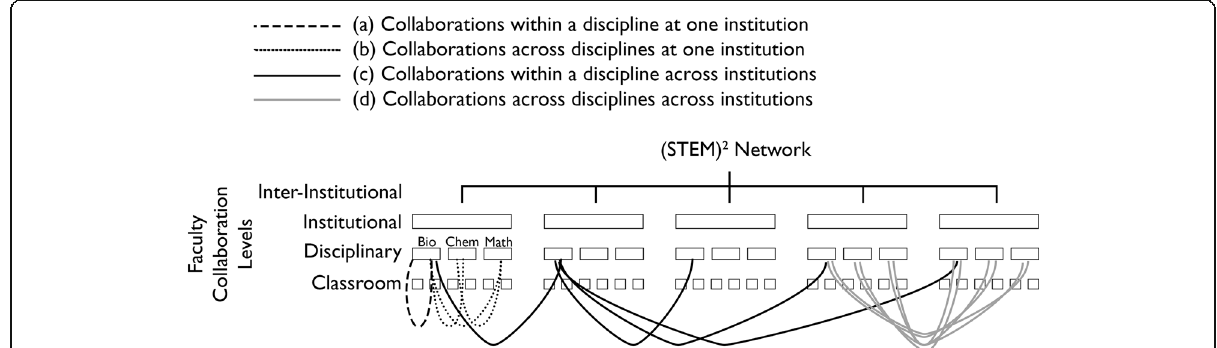
Fig. 1 Four levels of faculty collaboration promoted by participation in the (STEM) 2 Network. The Network spans the classroom, disciplinary, institutional, and inter-institutional levels. It creates on-going collaborations among faculty a within a discipline at one institution, b across disciplines at one institution, c within a discipline across institutions, and d across disciplines across institutions. Only a few examples of each collaboration type are illustrated for clarity